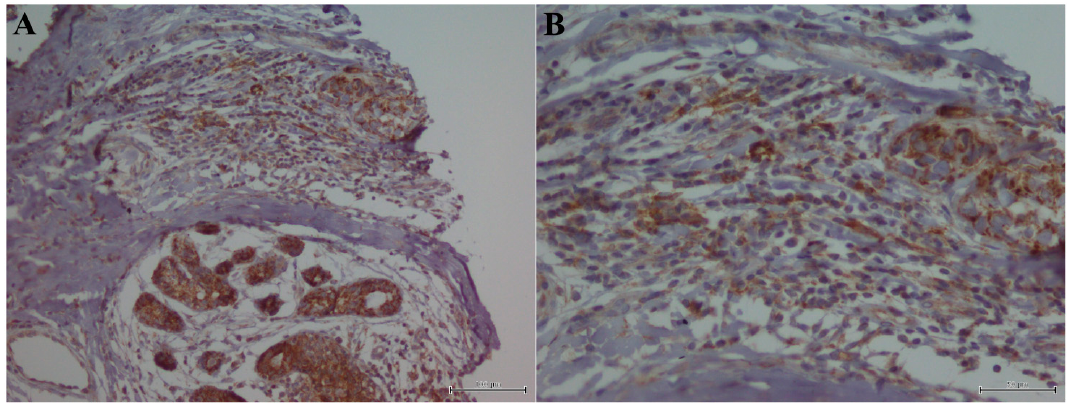
Figure 2. PD-L1 immunostaining in TIL: ( A ) TIL PD-L1+ cells (magnification 20×); and ( B ) detail of positive PD-L1 staining on TIL and tumor cells (magnification 40×).